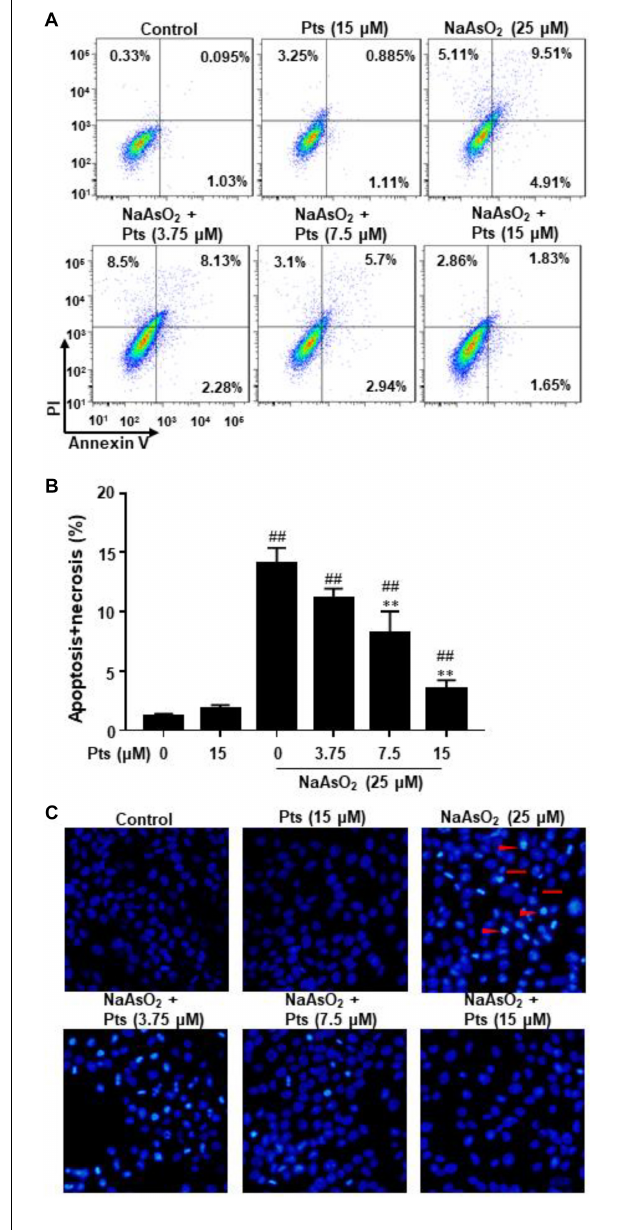
FIGURE 4 | Protective effect of Pts pretreatment against NaAsO 2 -induced apoptosis in HaCaT cells. The HaCaT cells were exposed to 25 µ M of NaAsO 2 for 24 h with or without Pts (3.75, 7.5, and 15 µ M) pretreatment. (A,B) The percentage of cell apoptosis was determined using flow cytometry. (C) Morphology of apoptotic cells was evaluated by fluorescence microscopy following DAPI staining at 200 × magnification. Triangles: nuclear chromatin condensation in apoptotic cells. Arrows: apoptotic bodies. The results are expressed as the means ± S.E.M. of three independent experiments. ## P ≤ 0.01 versus the control group, ∗∗ P ≤ 0.01 versus the NaAsO 2 group. or without pretreatment with Pts as mentioned above. After each experiment, the cells were washed twice with cold PBS. Whole-cell protein extracts were obtained using cell